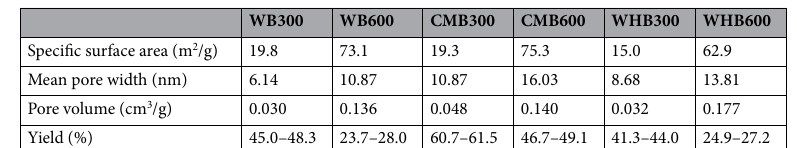
Table 1. Specific surface area, pore width and pore volume of In-house produced biochar samples.